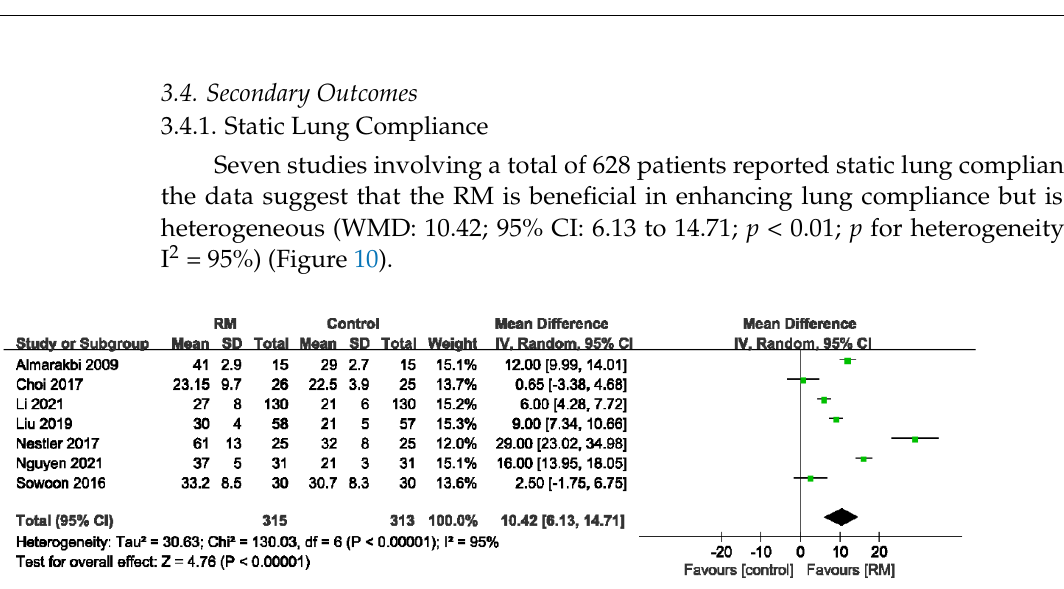
Figure 9. Forest plot for subgroup analysis of the incidence of PPCs between RM and control groups. Grouped by ZEEP or PEEP used in control group: compare to ZEEP, compare to PEEP [16 – 32].